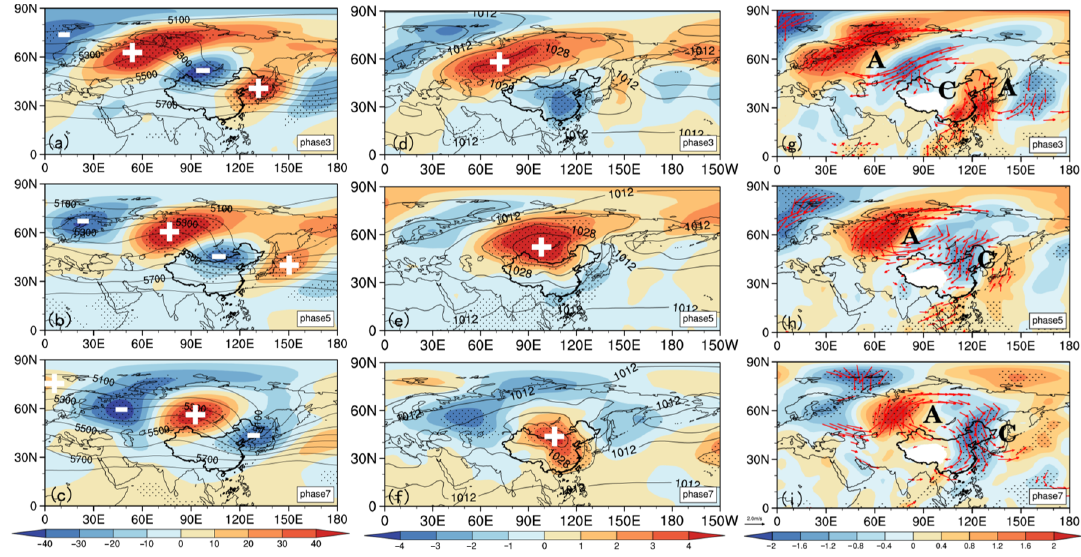
Figure 4. ( a – c ) 500 hPa geopotential height (unit: gpm), ( d – f ) SLP (unit: hPa) and ( g – i ) 850 hPa wind (vector, unit: m/s, the blank area is the Tibetan Plateau) and temperature (shaded, unit: K) measured in 28 RSCEs at phase 3, 5, and 7, respectively. (Shaded area: 10–20 d component; contour: unfiltered data; dotted area and red vector enclose regions of larger than 0.01 significance).